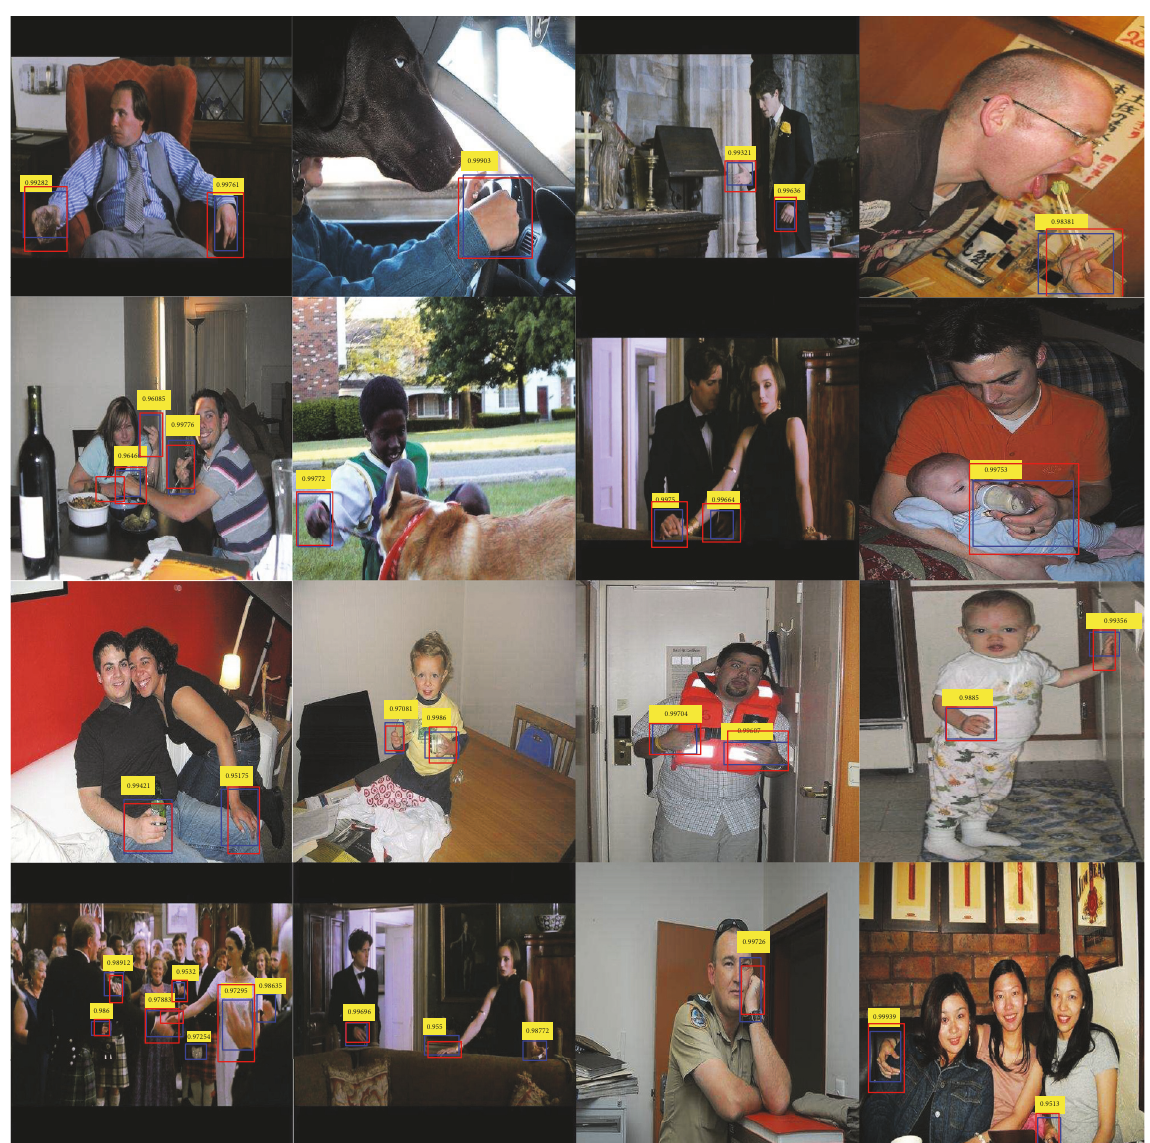
Figure 8: Detected examples from the Oxford Hand Detection Dataset: The red boxes are the annotated hand positions. The blue boxes are the detected boxes with the corresponding label tags showing the detection score in yellow.